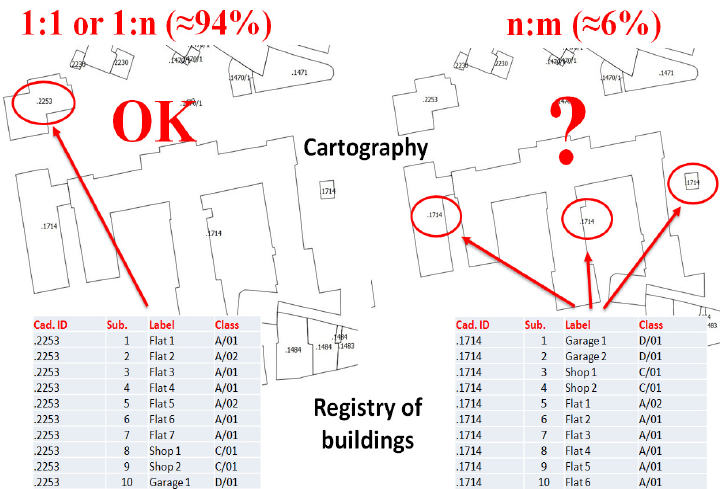
Figure 7 Example of cardinality problems encountered during integration of cadastral cartography with the registry of buildings. While for most of the cases (94%) a direct assignment of the units in the registry of property can be carried out automatically due to 1:1 or 1:n relations, the remaining 6% have to be solved manually.